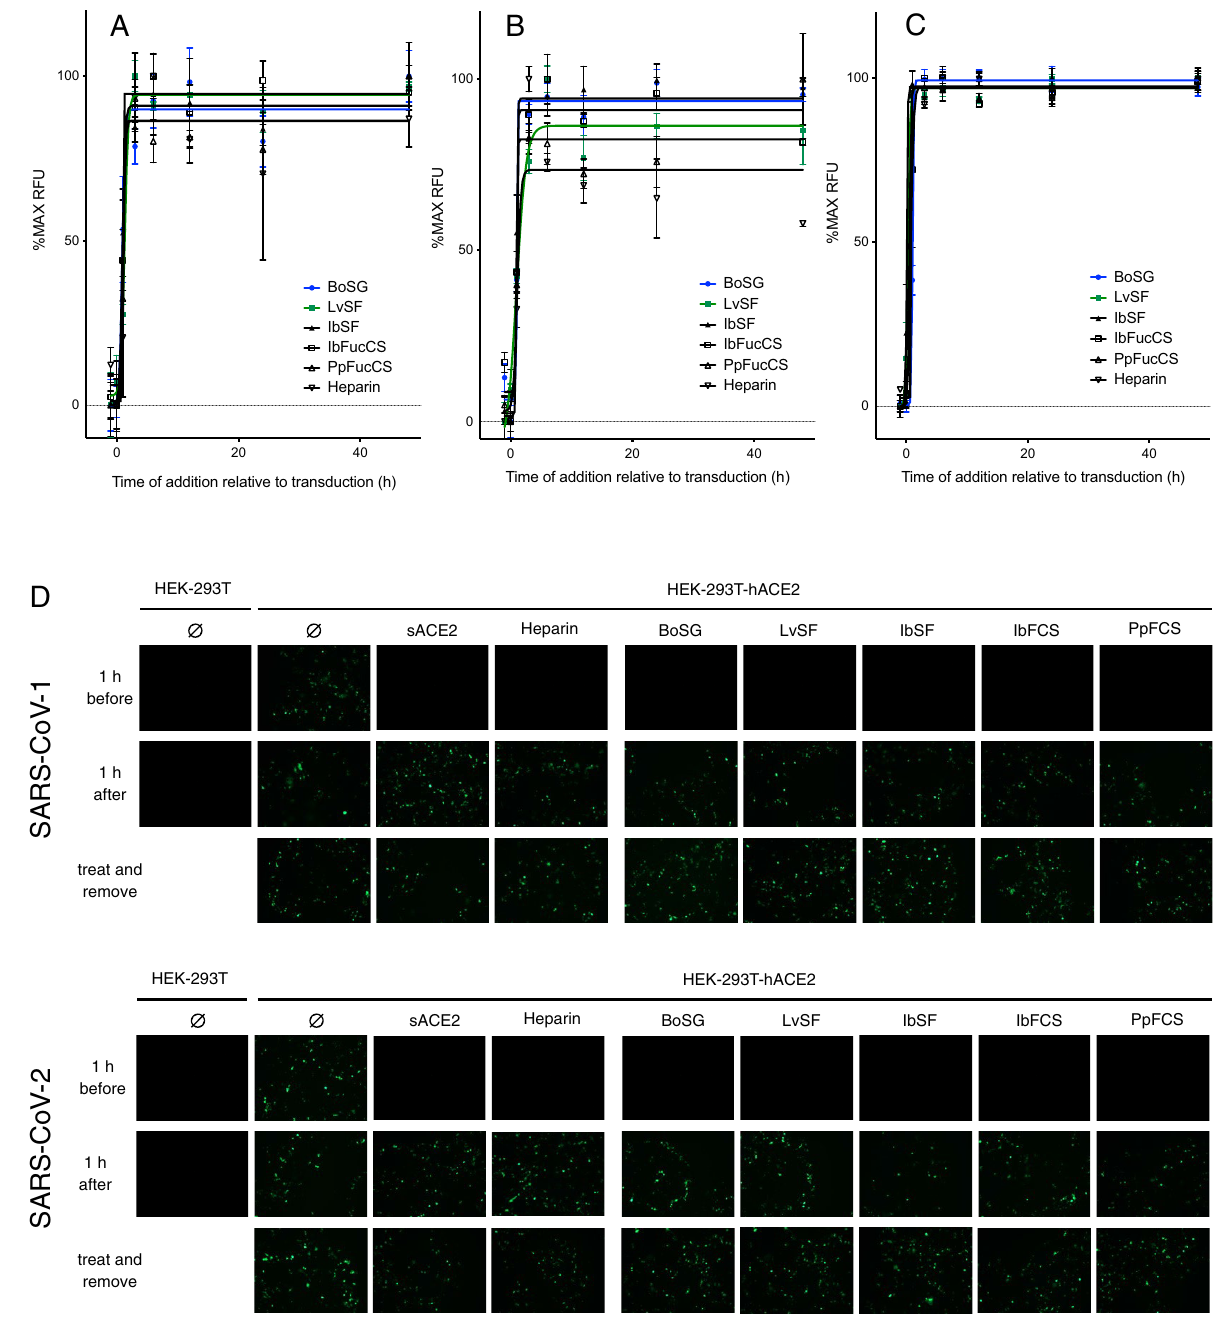
Figure 5. Time of addition studies. ( A – C ) Confluent HEK-293T-hACE2 monolayers were treated with 150 µg/ mL heparin or MSGs 1 h before, concurrent with, or at various times after addition of VLPs pseudotyped with spike proteins from SARS-CoV-1 (A), SARS-CoV-2 (B), or MERS-CoV (C). GFP expression was quantified 2 days after VLPs were added. Data are means of triplicate wells ± standard deviations. ( D ) Confluent HEK-293T or HEK-293T-hACE2 monolayers were treated with medium (Ø), 300 µg/mL soluble ACE2 (sACE2), or 150 µg/ mL heparin or MSGs either 1 h before or 1 h after addition of VLPs pseudotyped with spike proteins from SARS-CoV-1 or SARS-CoV-2. Representative fluorescent images were captured after incubation for 48 h. Treat and remove indicates replicate cultures that were treated as above for one h and then washed three times with medium prior to addition of